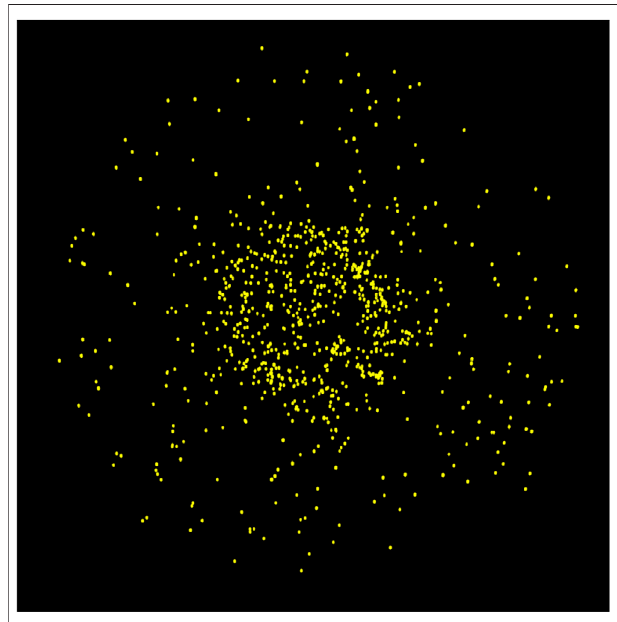
FIGURE 7 | Ray-traced image of the large porous grain type at the fi nal stage of ice build-up showing only the H 2 molecules and excluding the grain and all other ice species.